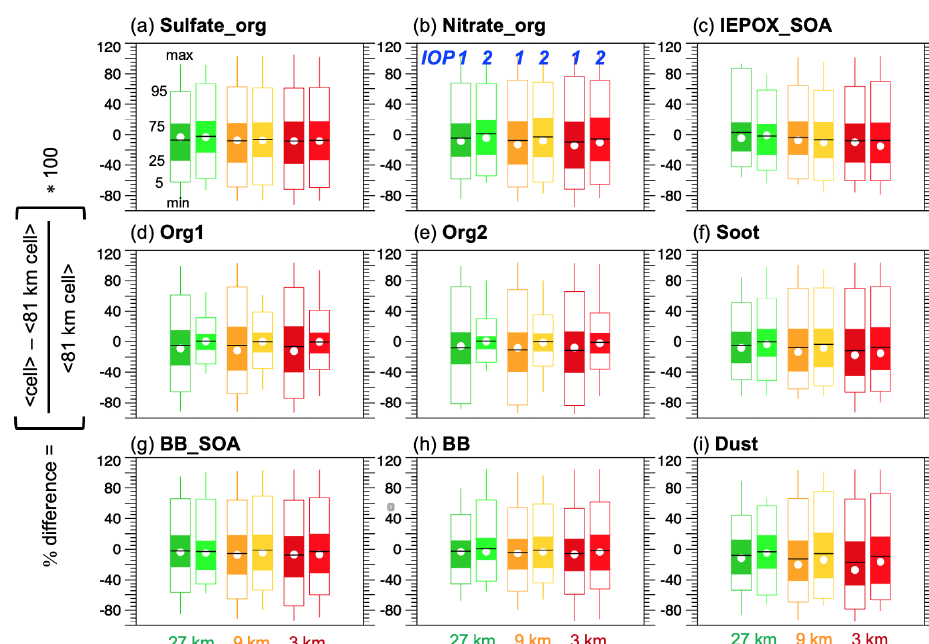
Figure 6. Percent difference between the SGP 81km cell average and the 27, 9, and 3km cell averages of (a) Sulfate_org, (b) Ni- trate_Org, (c) IEPOX_SOA, (d) Org1, (e) Org2, (f) soot, (g) BB_SOA, (h) BB, and (i) dust volume concentration classes from the min- iSPLAT instrument. The definition of percentiles and average values is the same as Fig. 5. All flights during IOPs 1 and 2 are grouped by the darker (left) and lighter (right) colors,